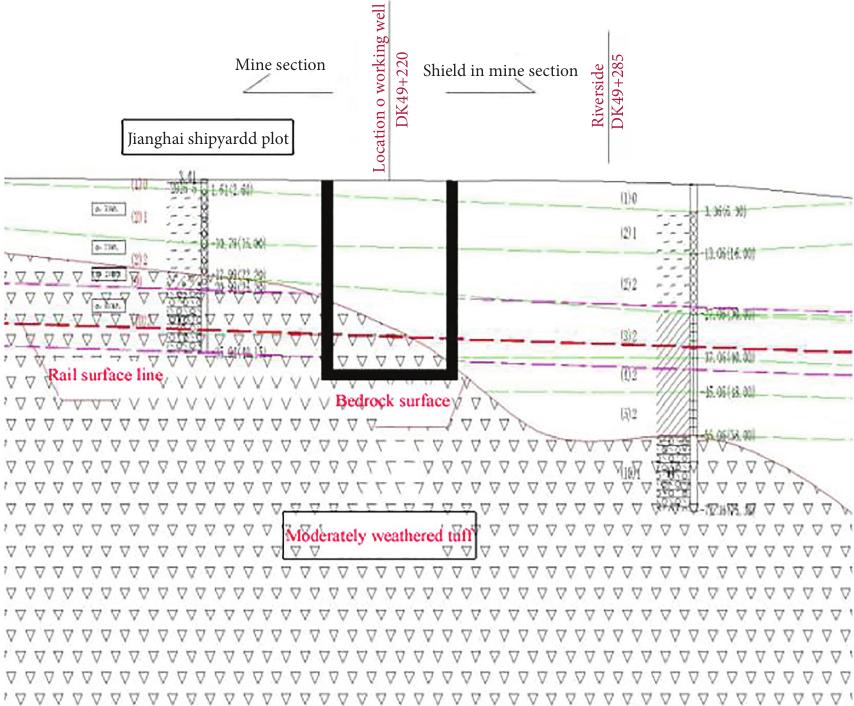
Figure 3: Geological profile of Jiangbei working well.